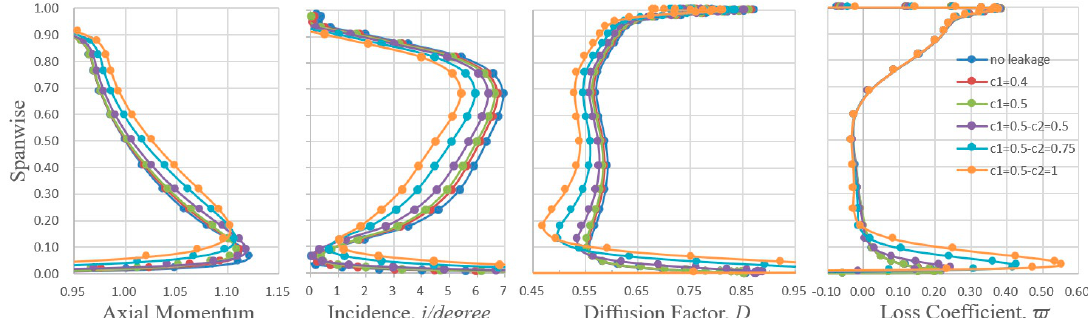
Figure 14. Spanwise distribution of blade element performance for Stator 2.